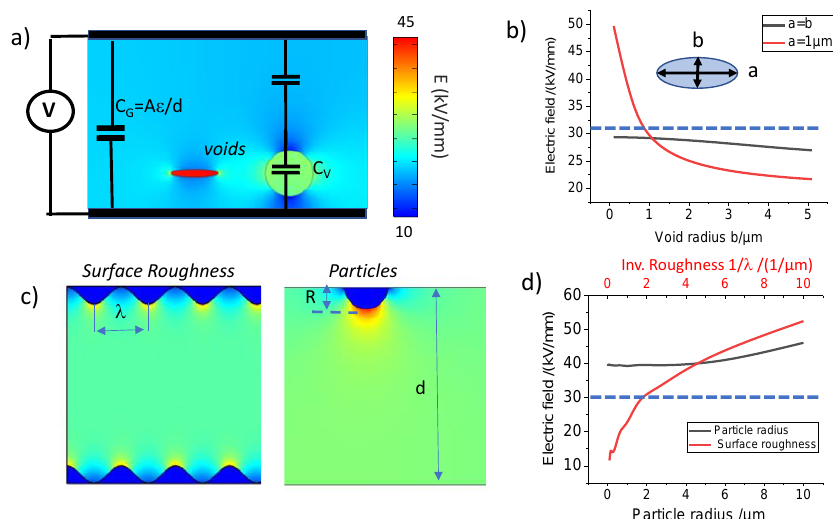
Figure 6. Finite element modeling of the defect structures and electrical fields, including the electrode roughness, contamination particles, and air voids in the separator. ( a ) Electric field strength in a solid 23 µ m thick separator (e r = 3) with air voids (e air = 1) of different ellipticity. The total capacitance (C G ) and the capacitance of the voids (C V ) are indicated. ( b ) Maximum field strength as a function of the void radii and ellipticity. ( c ) Electric field strength for a rough electrode surface and presence of conductive particles at the electrode–separator interface. ( d ) Maximum electrical field strength as a function of electrode surface roughness (upper axis) and conductive particle radius (lower axis).